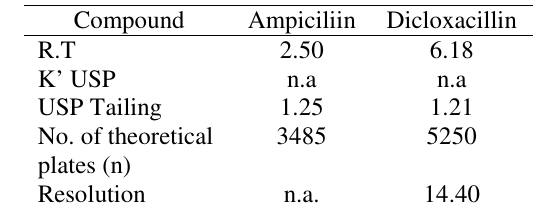
Table 4. Evaluation of chromatographic parameter for ampicillin and dicloxacillin capsules dosage form.